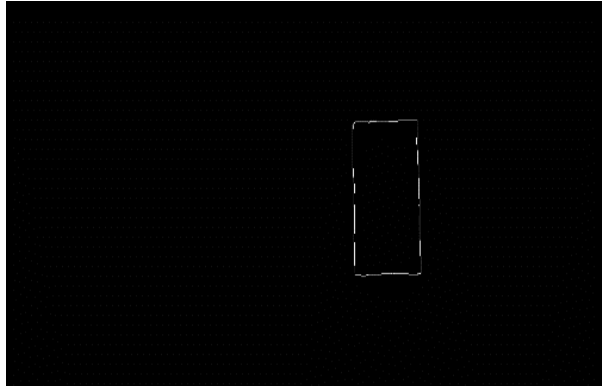
Figure 24. Upper and lower sides of the parking spaces.